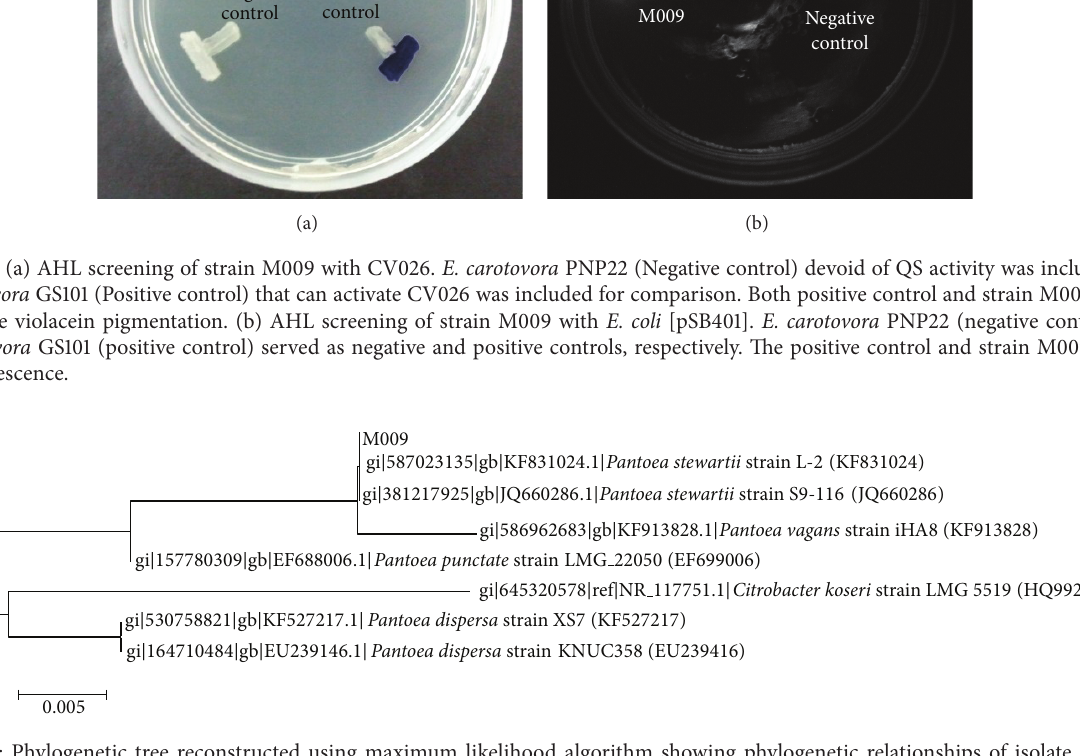
Figure 2: Phylogenetic tree reconstructed using maximum likelihood algorithm showing phylogenetic relationships of isolate M009 to members of other species of the genus Pantoea . There are a total of 1220 positions in the final dataset. Bar, 5 substitutions per 1000 nucleotide